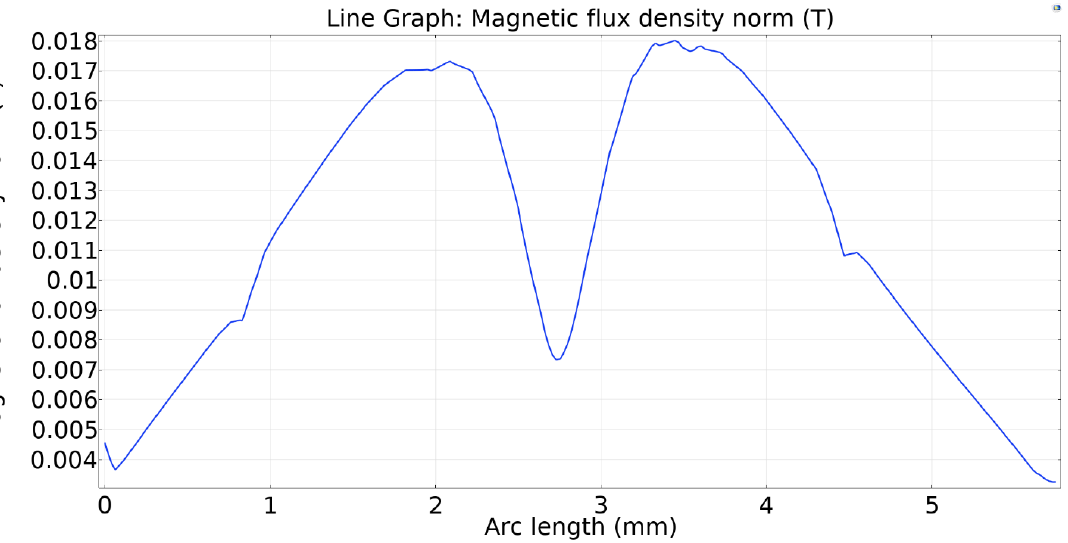
Figure 9. Magnetic flux density over the upper MRE wall under the magnetic field for the five valve models.